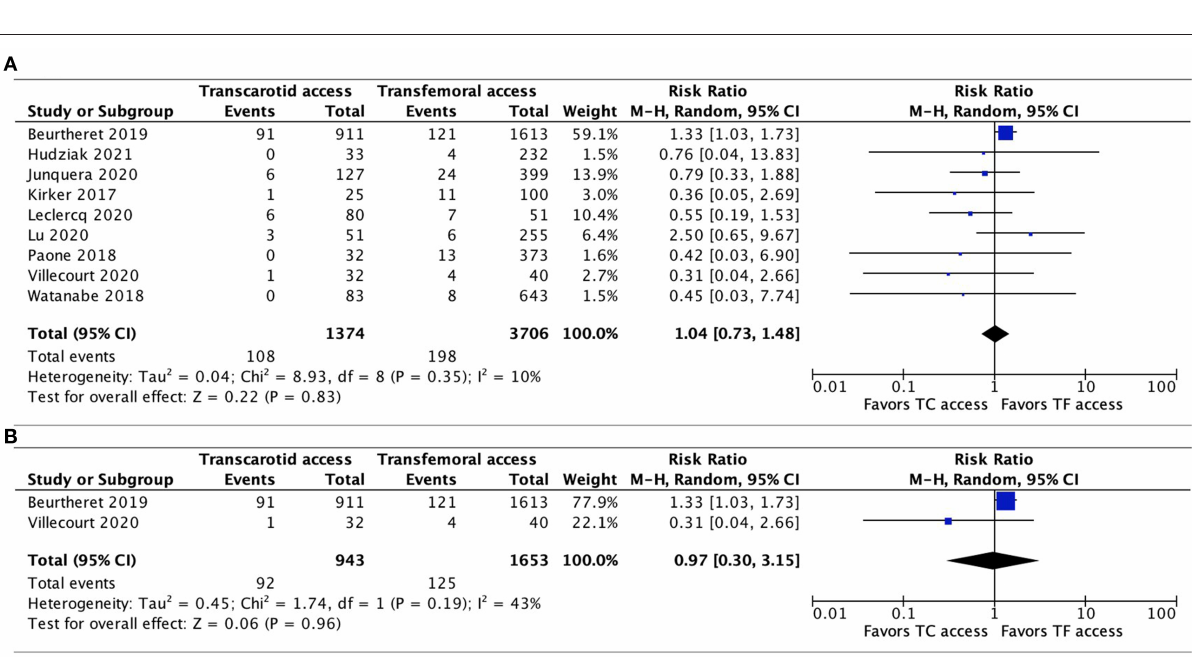
FIGURE 6 | Forest plots comparing major bleeding between TC and TF transcatheter aortic valve replacement procedures. (A) Pooled data from all studies. (B) Data from propensity-score matched study. TC, transcarotid; TF,